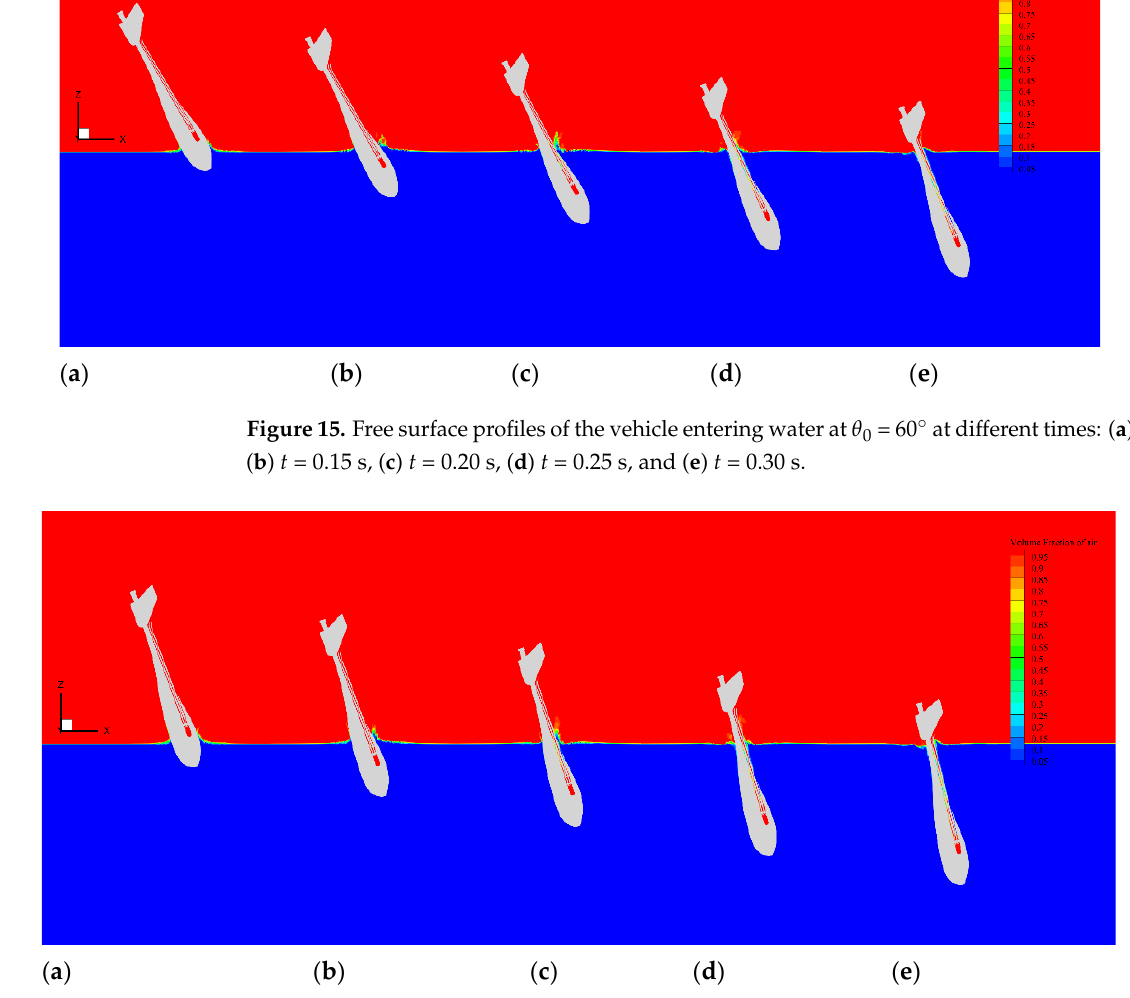
Figure 16. Free surface profiles of the vehicle entering water at θ 0 = 70° at different times: ( a ) t = 0.10 s, ( b ) t = 0.15 s, ( c ) t = 0.20 s, ( d ) t = 0.25 s, and ( e ) t = 0.30 s.